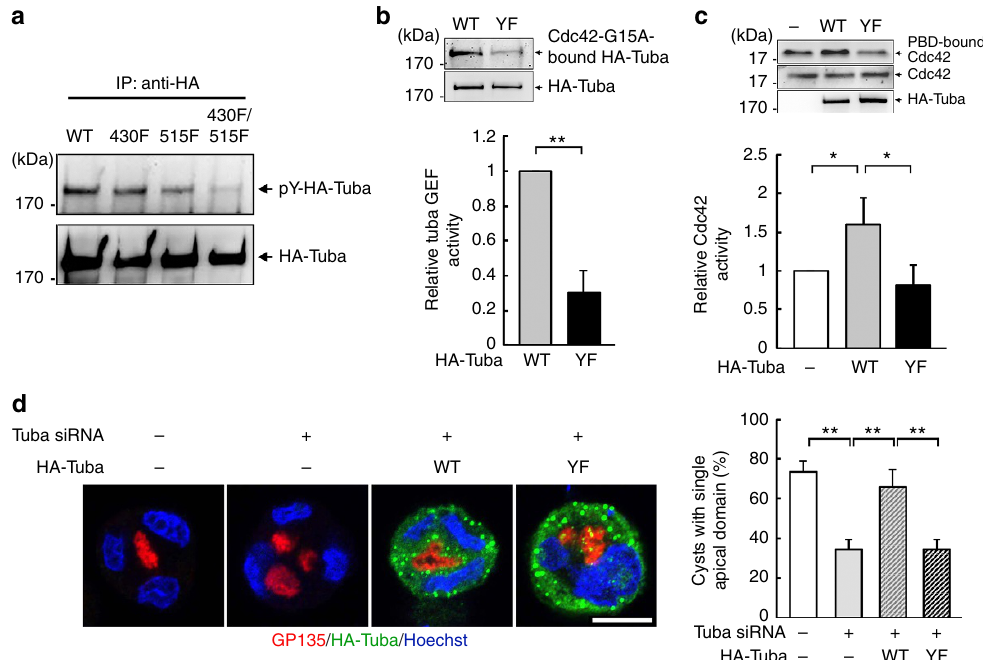
Figure 3 | Dephosphorylation at Y430/Y515 by oncogenic Shp2 impairs Tuba-mediated Cdc42 activation and normal lumen formation. ( a ) HEK293T cells were transiently transfected with HA-Tuba of WT and various mutants carrying Y - F mutation as indicated. Cells were treated with pervandate (50 m M) for 5min before harvested for immunoprecipitation with anti-HA antibody. The immunoprecipitates were analysed by western blot with anti- phosphotyrosine (4G10) antibody followed by reporbing with anti-HA antibody. ( b , c ) HEK293Tcells were transfected with control vector or HA-Tuba WT or YF (Y430/515F) mutant and harvested for ( b ) measuring GEF activity of HA-tuba by GST-Cdc42-G15A pull-down assay, and ( c ) endogenous Cdc42 activity by GST-PBD pull-down assay. The relative Cdc42 and HA-Tuba GEF activity from three independent experiments are shown. ( d ) MDCK cells were co-transfected with Tuba siRNA and WTor 430/515YF mutant of HA-Tuba and then cultured in Matrigel for 2 days. Cysts were extracted for IF staining with anti-GP135 (red) and anti-HA (green) antibodies and Hoechst (blue), scale bar,10 m m. The percentage of cysts with single apical patch is shown on the right (113–179 cysts were counted in each experiment, n ¼ 3). Data are presented as mean ± s.d. from three independent experiments; two-tailed unpaired Student’s t -test. * P o 0.05, ** P o